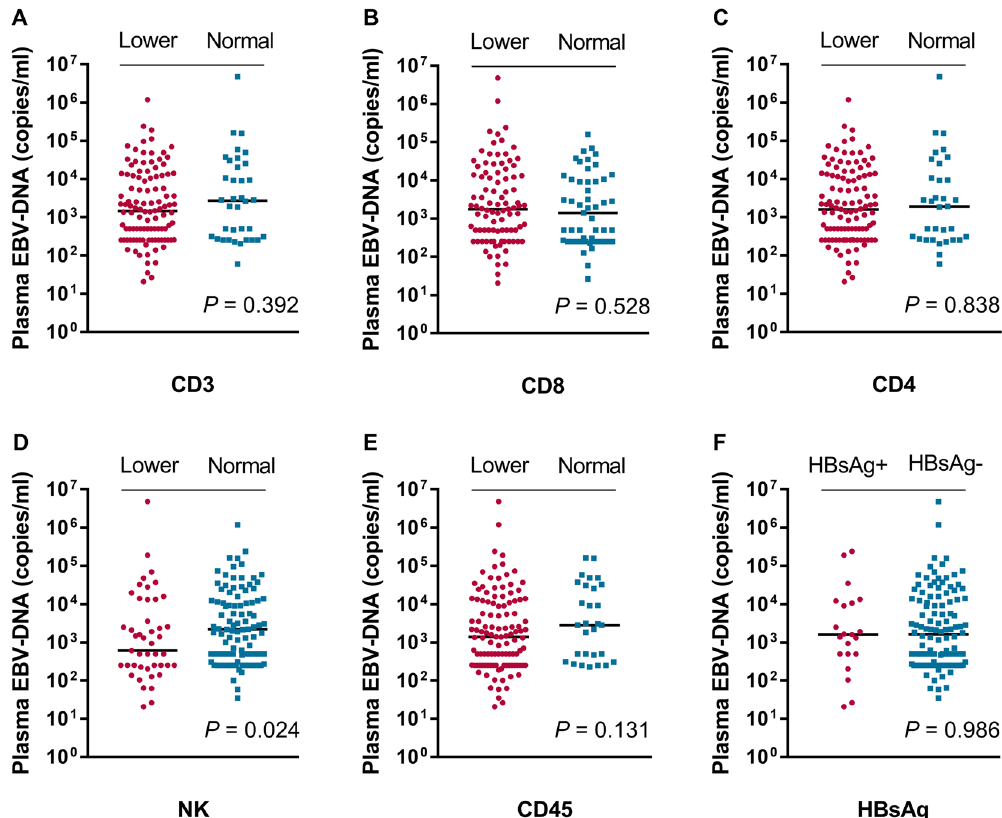
Figure 1. Comparison of EBV DNA load in patients with NPC between the different status of the immunity parameter ( A – E ) and HBsAg ( F ). Lower: indicate that the value is lower than the normal range; Normal: indicates that the value is in the normal range or higher than the normal